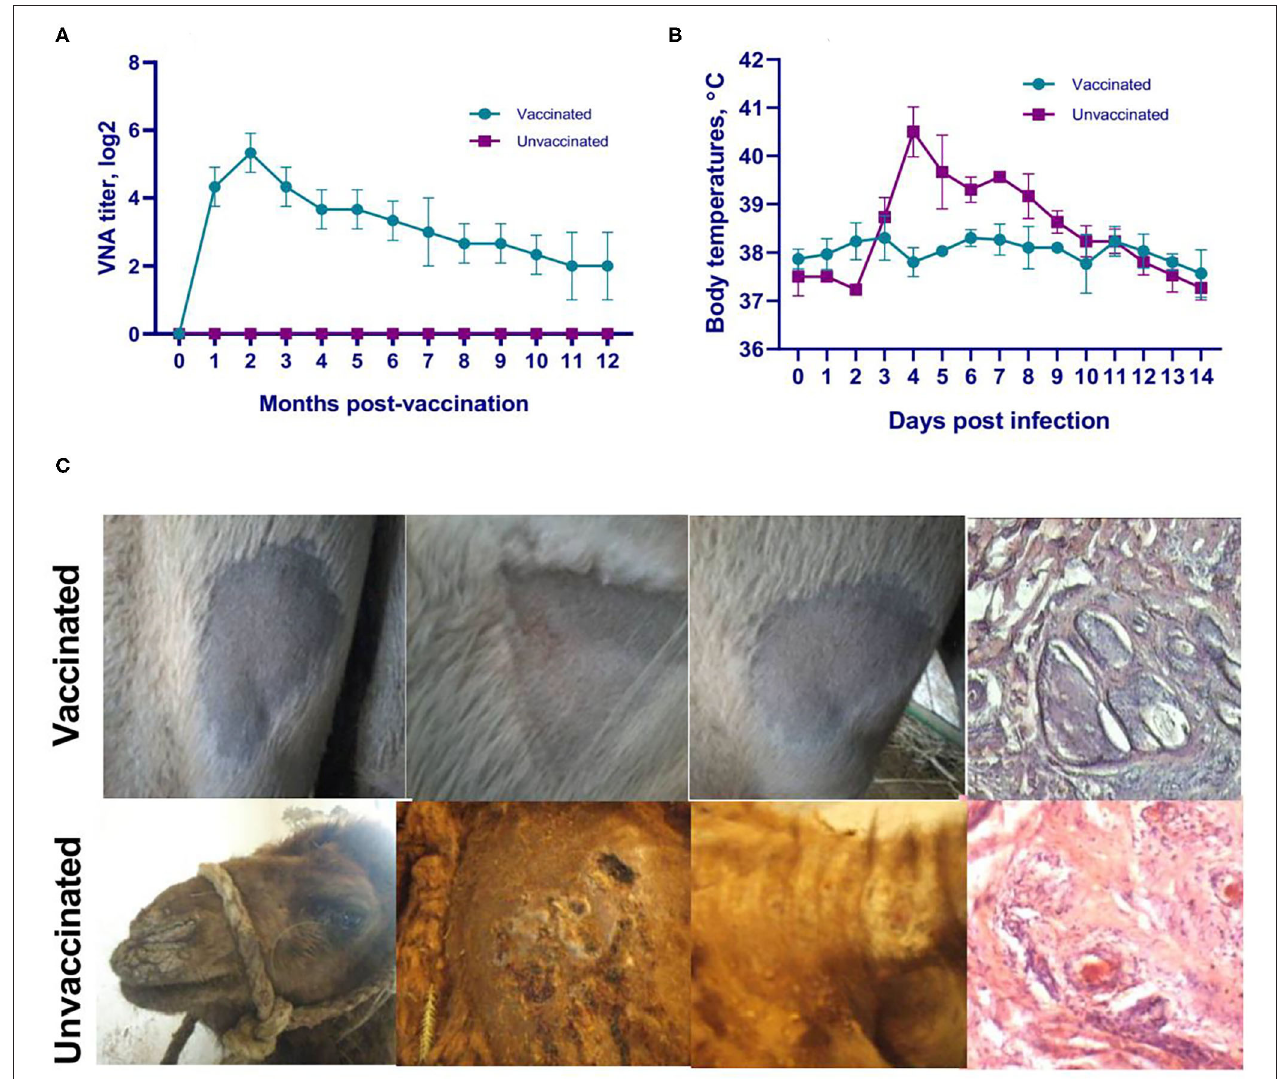
FIGURE 6 | Evaluation of duration of the immune response and protective efficacy of the camelpox vaccine. (A) Dynamics of VNA formation in sera of vaccinated animals against camelpox. VNA are formed starting from days 6–7 and are detected even at 12 months in titers ensuring immunity of vaccinated animals to the virulent wild-type M-96 strain at the dose of 10 5.0 EID 50 . (B) Temperature response of vaccinated and unvaccinated camels after challenge. (C) Cutaneous reaction and dermal histopathology of vaccinated and unvaccinated camels after challenge (multilayer squamous epithelium at the scarification area is relatively thin, the borders of the papillary and reticular layers of the skin are distinguishable, and primary and secondary follicles and other components of the skin base are visible). Formation of papules and vesicles in places of virus inoculation in unvaccinated animals was observed on 7–9 days, also on the skin of lips, outer part of nose wings, hind legs, head with subsequent formation of pox crusts on 10–14 days. The candidate vaccine induced an immune response that provided a statistically significant reduction in the severity of clinical signs of camelpox ( P < 0.0001) and 100% protection ( P <